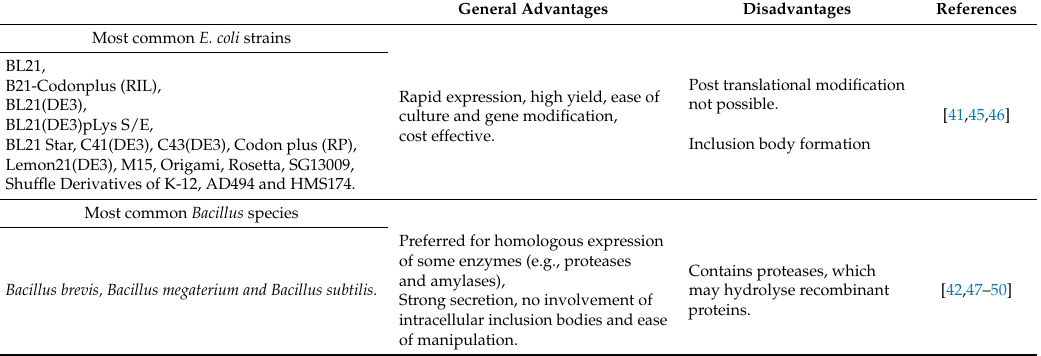
Table 1. Summary of the most widely used recombinant expression strains from E. coli and Bacillus species outlining their advantages and